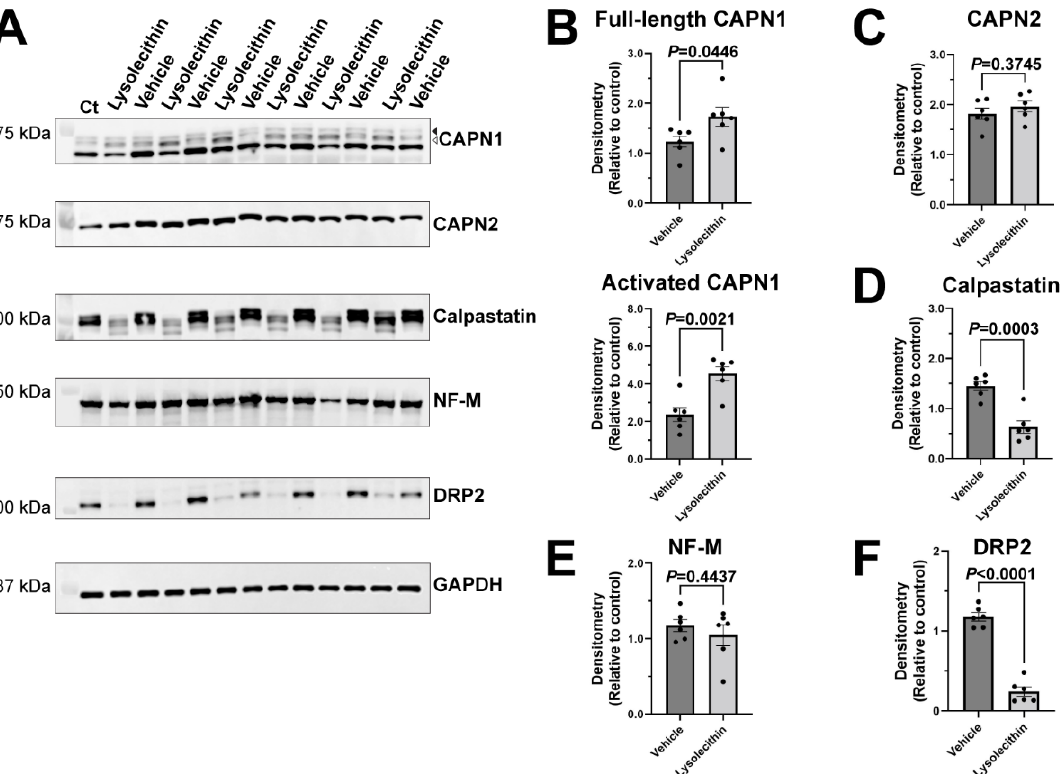
Figure 5. Calpain and calpastatin expression 6 days after a lysolecithin induced demyelination injury of rat sciatic nerves. ( A ) Immunoblotting images 6 days after lysolecithin induced injury. Ct represents a control homogenate from an uninjured sciatic nerve of an adult rat to be used as the reference lane. Full-length CAPN1 (arrowhead at 80 kDa), activated CAPN1 (open arrowhead at 76/78 kDa), CAPN2 and calpastatin levels were examined. Neurofilament (NF)-M expression was examined to determine the extent of axonal damage at the location of injections, and dystrophin-related protein 2 (DRP2) was examined to determine the amount of demyelination. GAPDH was examined as an internal loading control. Some molecular weight markers were overlaid to better illustrate band locations. ( B – F ) Quantitative analysis of immunoblot data 6 days after a lysolecithin induced injury. Relative density was quantified for the full-length CAPN1 and the activated form of CAPN1 ( B ), CAPN2 ( C ), calpastatin ( D ), NF-M ( E ), and DRP2 ( F ). Data are normalized to internal lane loading control (GAPDH). Student’s t -test was used for two group comparisons between the lysolecithin and vehicle-injected groups. Mean ± SEM graphed with n = 6 rats. Detailed results of statistical analyses are provided in the Supplementary Information S4.